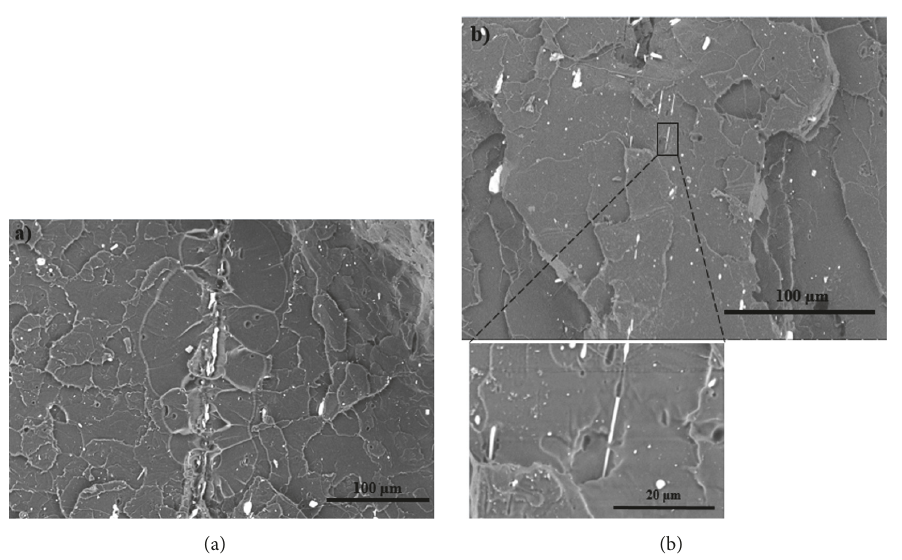
Figure 20: SEM micrograph of the fracture surface of PLA loaded with P-glass at 10% by weight printed at (a) 220 ∘ C and (b) 260 ∘ C.